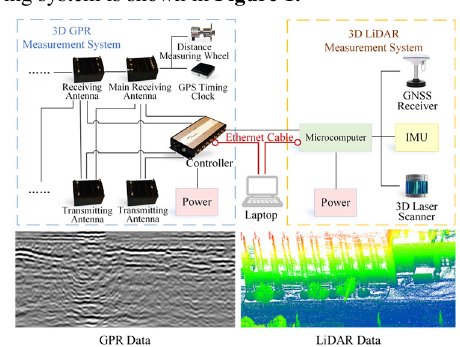
Figure 1. Composition of the integrated ground and under- ground 3D surveying